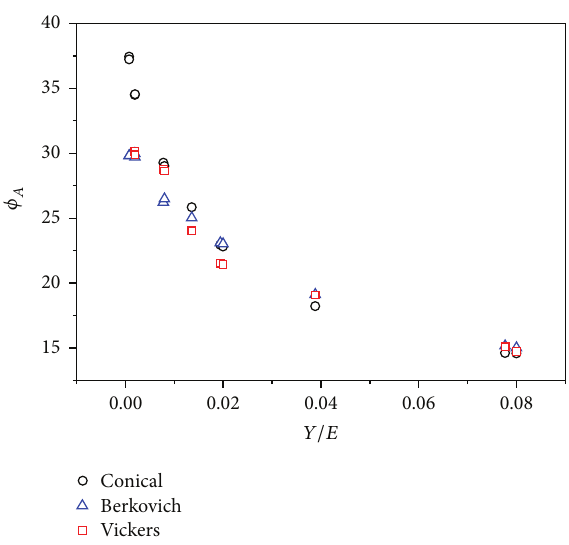
Figure 6: The variation of dimensionless function 𝜙 𝐴 = 𝐴/ℎ 2 with respect to 𝑌/𝐸 for different kinds of indenters.